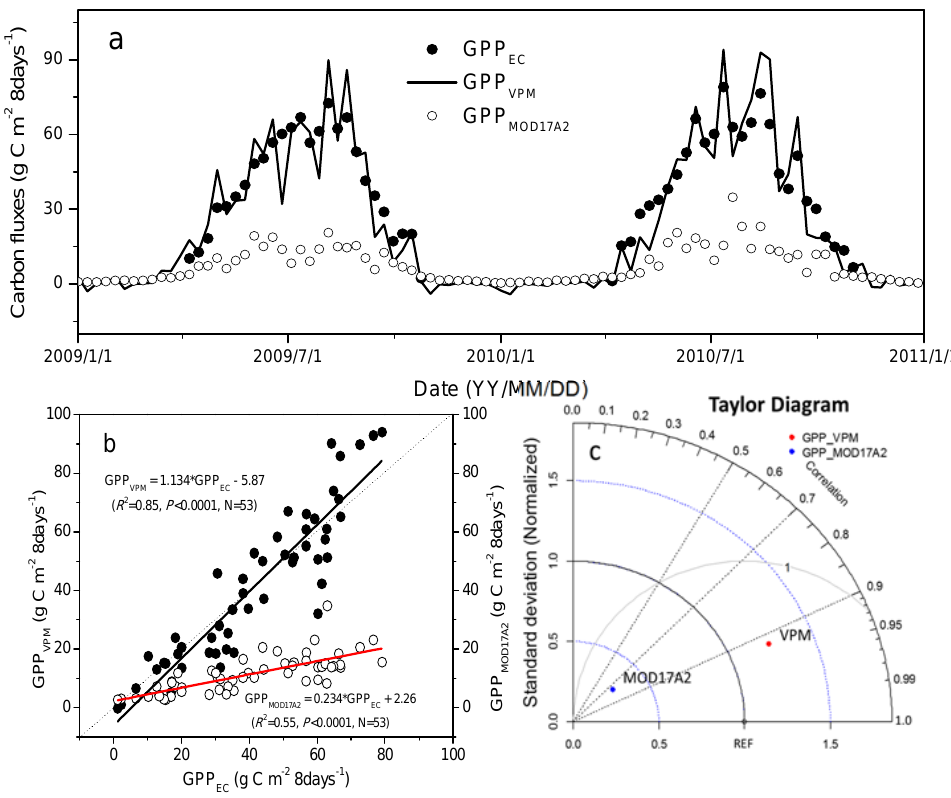
Figure 9. Comparisons between the estimated gross primary production from the flux tower (GPP EC ) and simulated gross primary production by VPM (GPP VPM ) and MODIS global GPP data product (GPP MOD17A2 ) in the typical coastal wetland during 2009–2010. Taylor diagram provides a visual comparison between two model results, or, most commonly, between model results and observations [71].